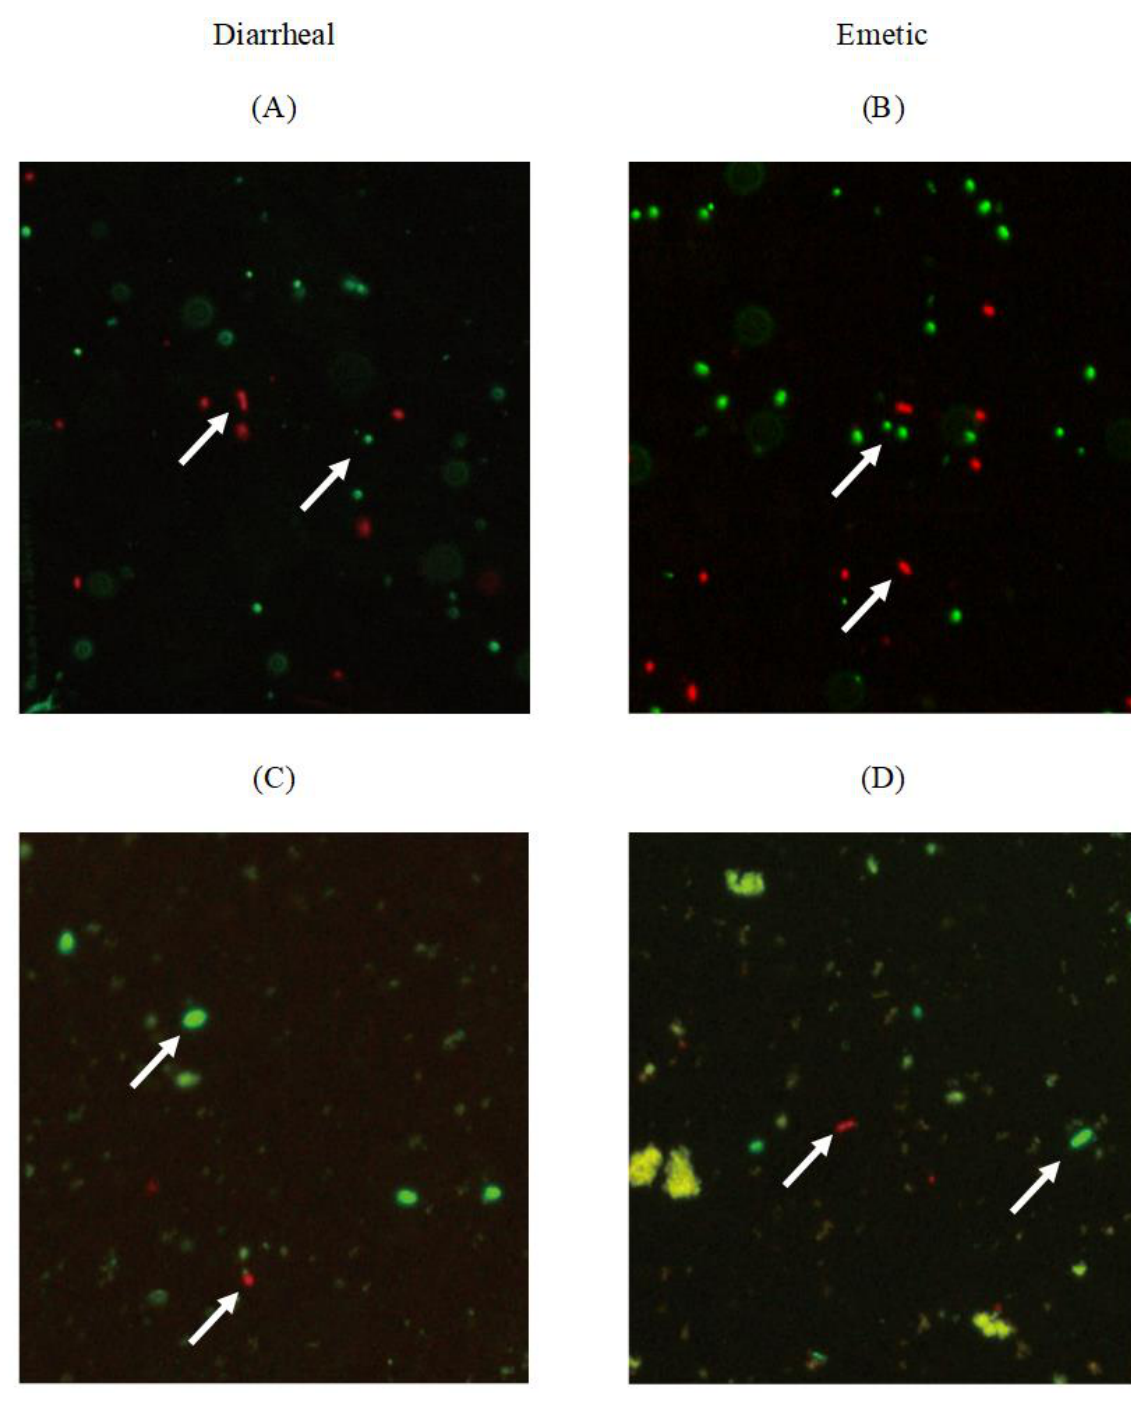
(Figure 2B) coexisted as live cells (fluorescent green) and dead cells (fluorescent red). Most cells were stained green, indicating live state when biofilm formed on stainless steel surfaces. Transferred diarrheal B. cereus (Figure 2C) and emetic B. cereus (Figure 2D) of biofilm cells to tofu also coexisted as live and dead cells, indicating possible regrowth of biofilm cells in tofu. Microorganisms 2019 , 7 , x